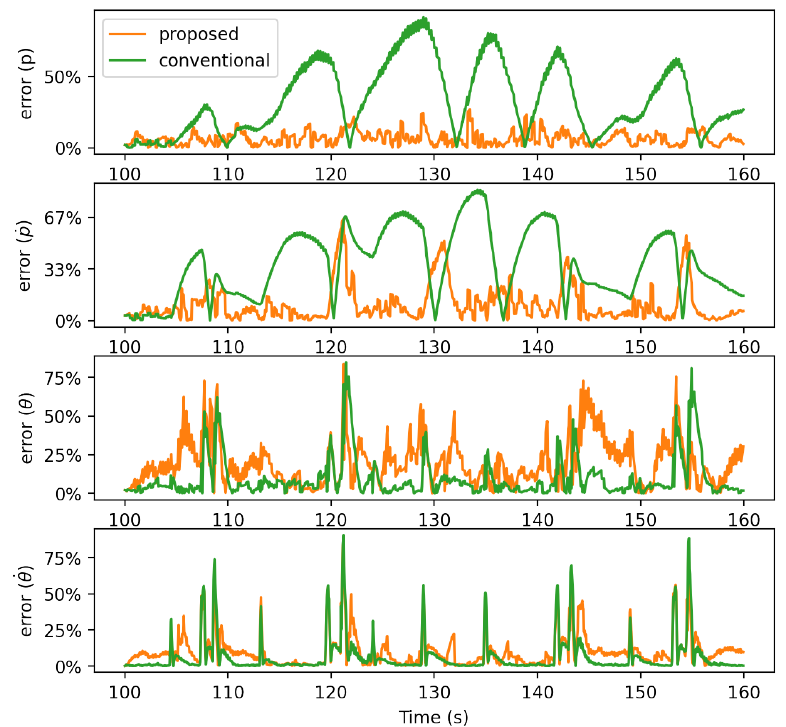
Figure 13. Absolute error of mean estimated by the proposed and the conventional approaches.